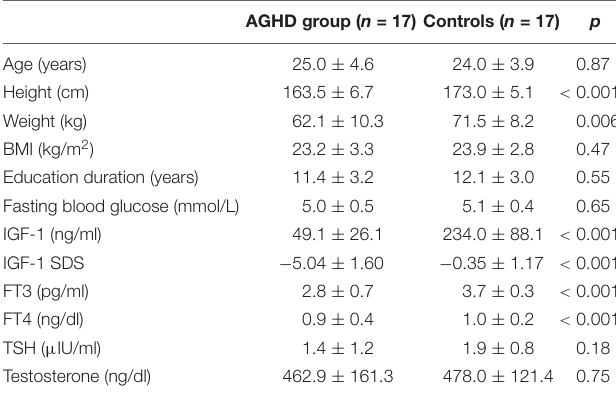
TABLE 1 | General baseline data and distribution of all